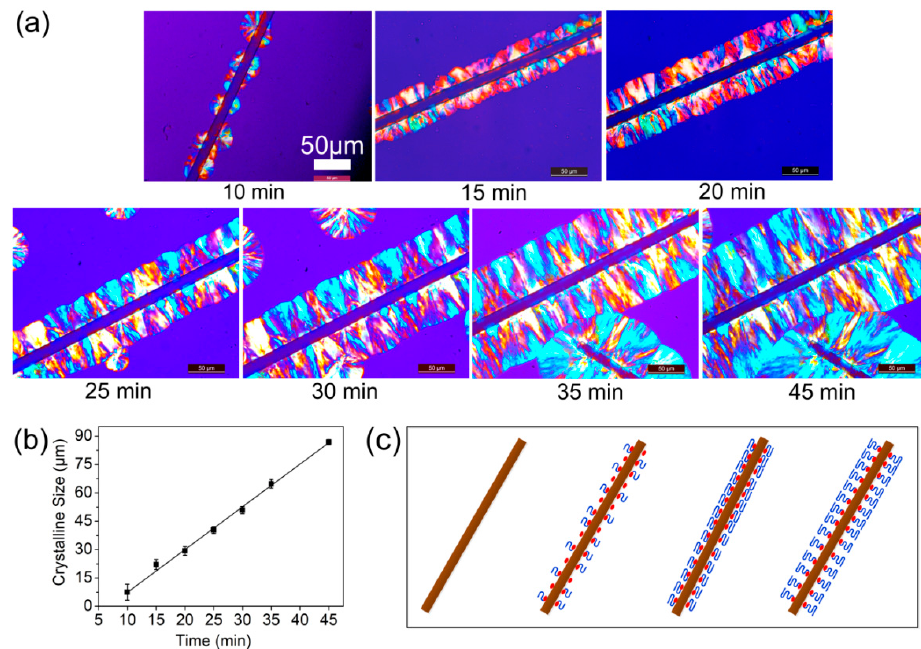
Figure 4. ( a ) The growth of transcrystallization (TC) on MBF of PBS/MBF (98/2) composites crystallized at 89 °C with different time; ( b ) thickness of TC layer; ( c ) schematic illustration of TC structure.